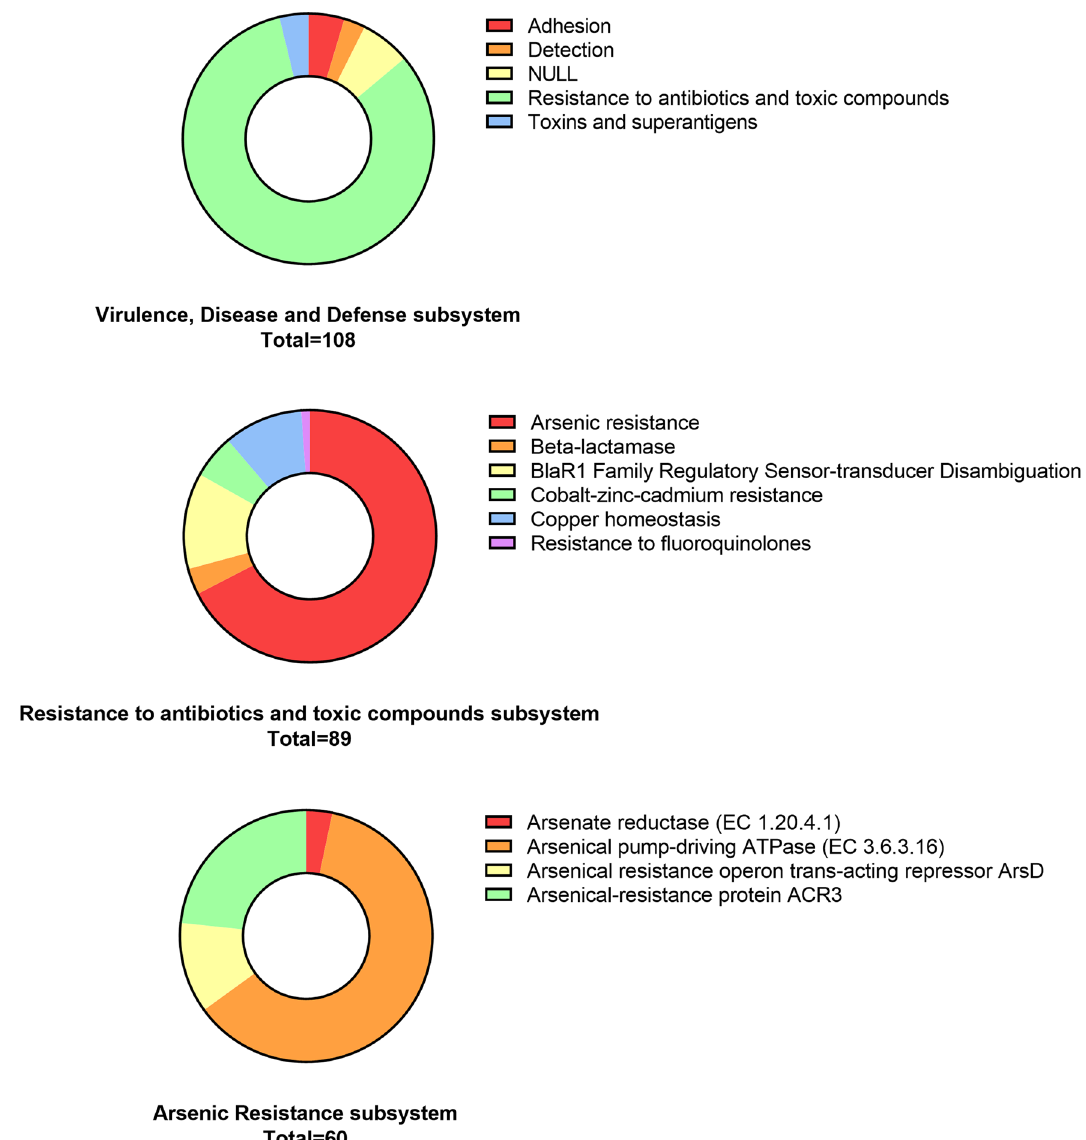
Figure 3. Predicted functional profile of the Diamante Lake plasmidome. On top, “Virulence, Disease and Defense” subsystem level 2 classification of the SEED database. In the middle, “Resistance to antibiotics and toxic compounds” subsystem level 3 classification of the SEED database. On the bottom, “Arsenic resistance” subsystem level 4 classification of the SEED database ( E -value ≤ 10 –5